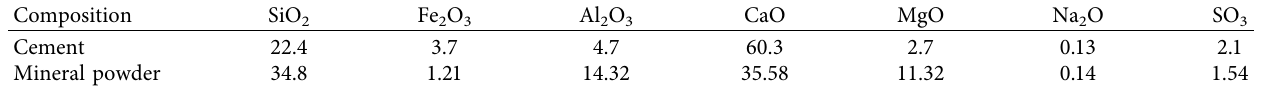
Table 1: Chemical compositions of cement and mineral powder in mass (%).